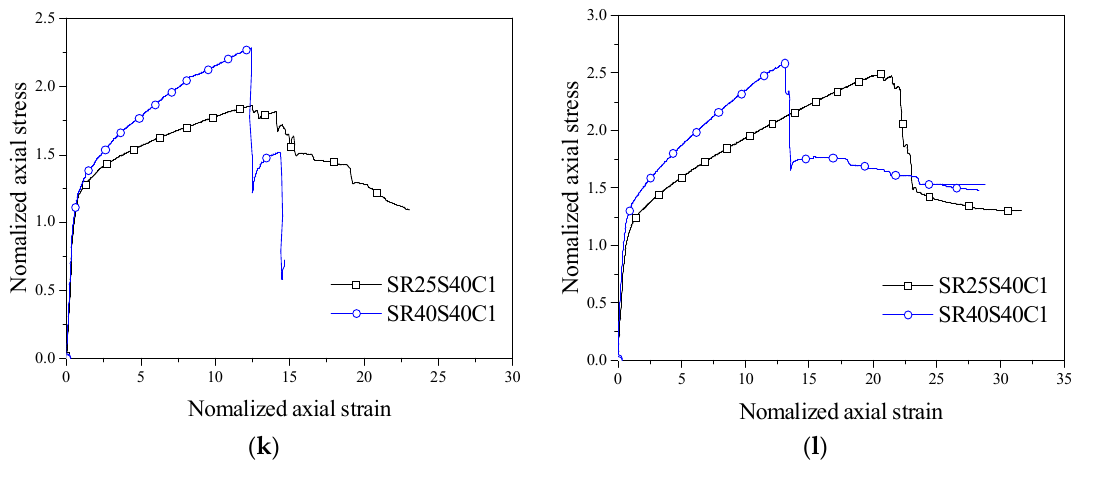
Figure 7. Effect of the corner radius on the stress–strain relationship curves: ( a ) S20BN series; ( b ) S20B1 series; ( c ) S20B2 series; ( d ) S40BN series; ( e ) S40B1 series; ( f ) S40B2 series; ( g ) S20CN series; ( h ) S20C1 series; ( i ) S20C2 series; ( j ) S40CN series; ( k ) S40C1 series; ( l ) S40C2 series.